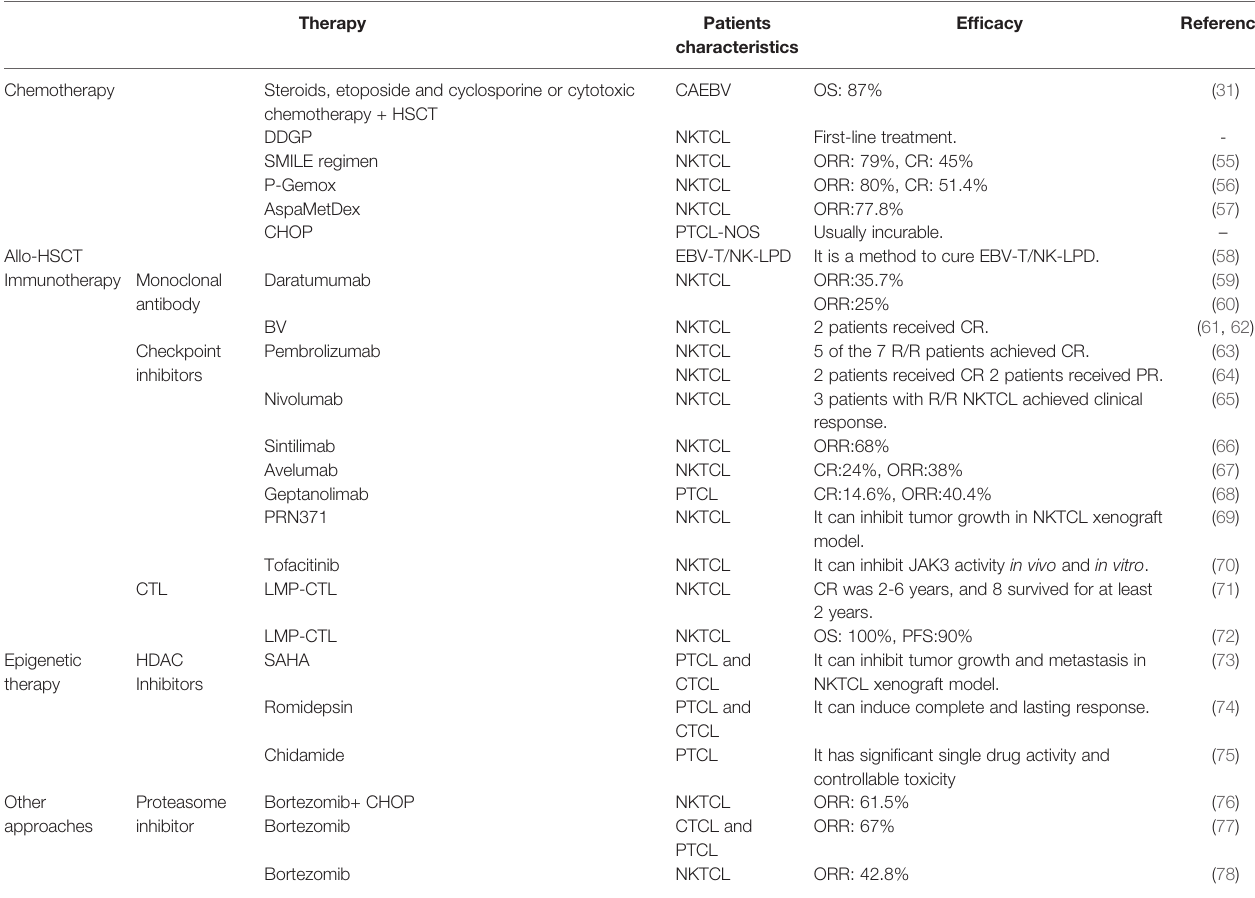
TABLE 2 | Summary of available therapies in